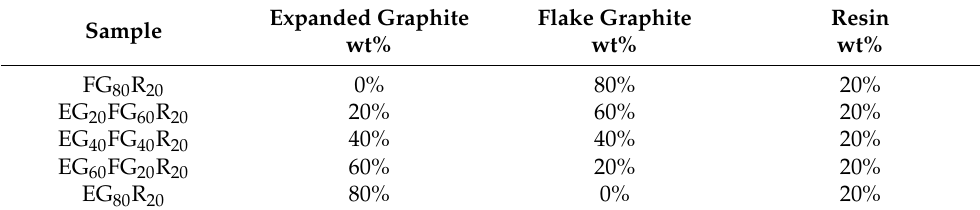
Table 1. Ratio(wt%) of EG, FG and resin for different samples.